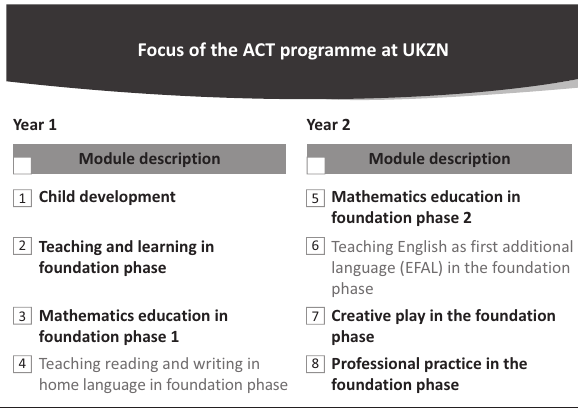
FIGURE 1: The structure of the Advanced Certificate in Teaching intended